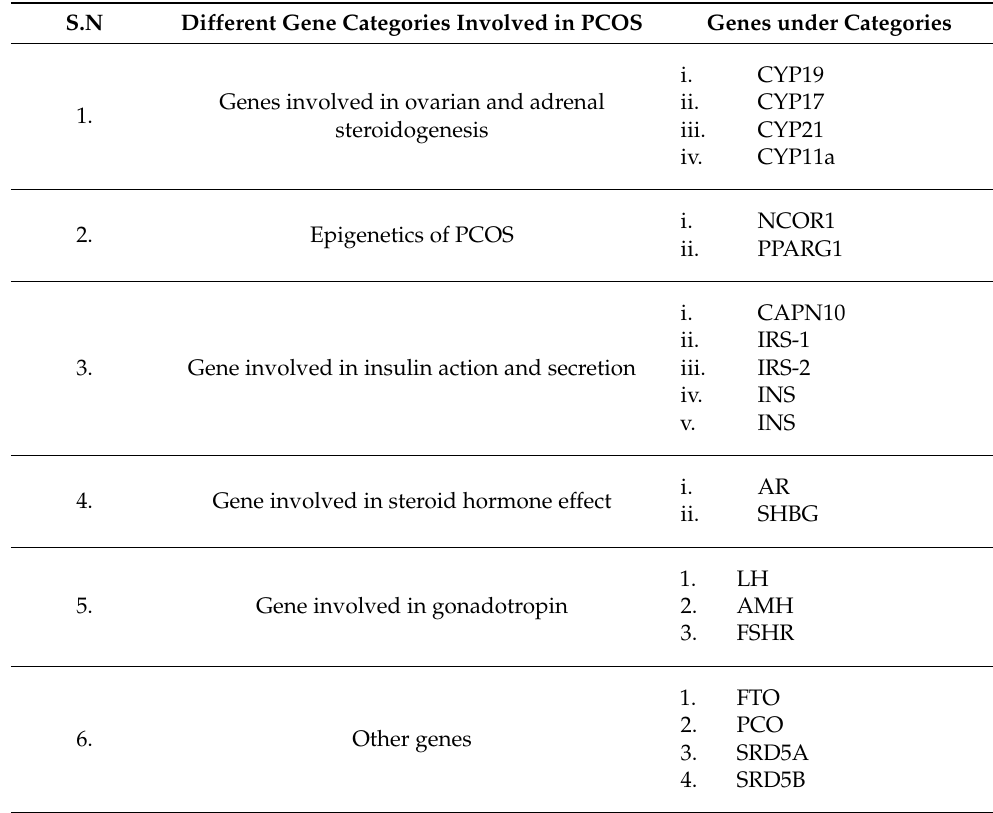
Table 4. Different Genes Involved in Pathogenesis of